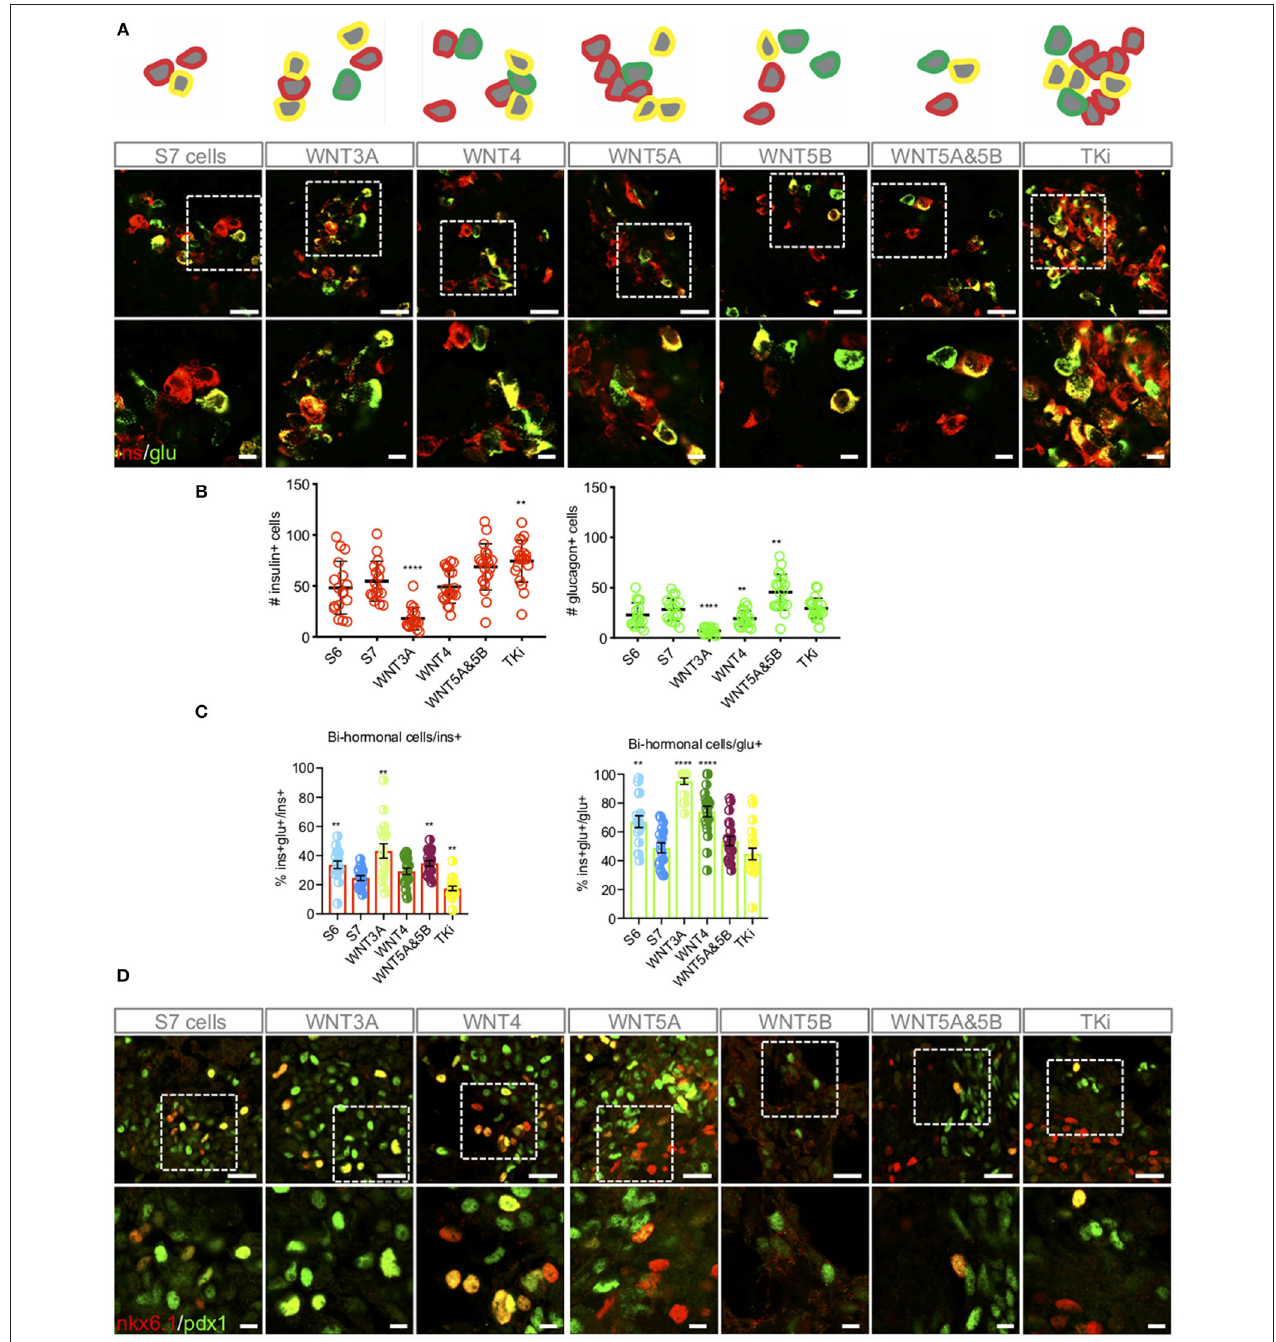
FIGURE 3 | Wnt-modulation influences the distribution of mono-hormonal and bi-hormonal S7 cells. (A) Representative schematic drawing and IF analysis for insulin + (red), glucagon + (green) cells and insulin + /glucagon + cells (yellow) of the respective S7 cell populations. (B) Calculations of insulin + (red, left) and glucagon + (green, right) cells were done as described in Methods. The y-axis shows the number of insulin + and glucagon + cells, respectively. The figure shows standard error of the mean (SEM) values for each of the columns in bar charts. ** P < 0.006, **** P < 0.0001 vs. S7 cells with two-tailed t -test. No significant comparisons show no stars. The number of insulin + cells and glucagon + cells were normalized to total cell count (dapi + cells) see Supplementary Figure 2 . (C) Overlay of insulin + and glucagon + were used to count bi-hormonal cells, in which bi-hormonal (ins + glu + ) cells were calculated as a fraction of insulin + (red bar chart) and glucagon + (green bar chart) cells, respectively. The figure shows standard error of the mean (SEM) values for each of the columns in bar charts. ** P < 0.006, **** P < 0.0001 vs. S7 cells with two-tailed, type two t -test. No significant comparisons show no stars. (D) IF analysis of NKX6.1 + (red), PDX1 + (green) cells and NKX6.1 + /PDX1 + cells (yellow). Scale bar upper panel: 25 µ m, lower panel: 7.5 µ m.